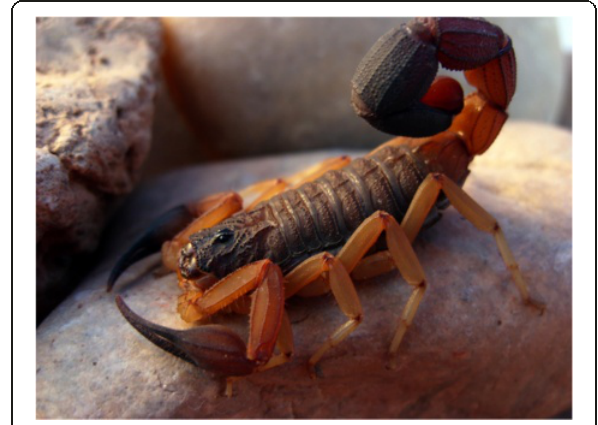
Fig. 18 Rhopalurus rochai Borelli, 1910; female from Brazil (copyright by Tiago Porto, reproduced with